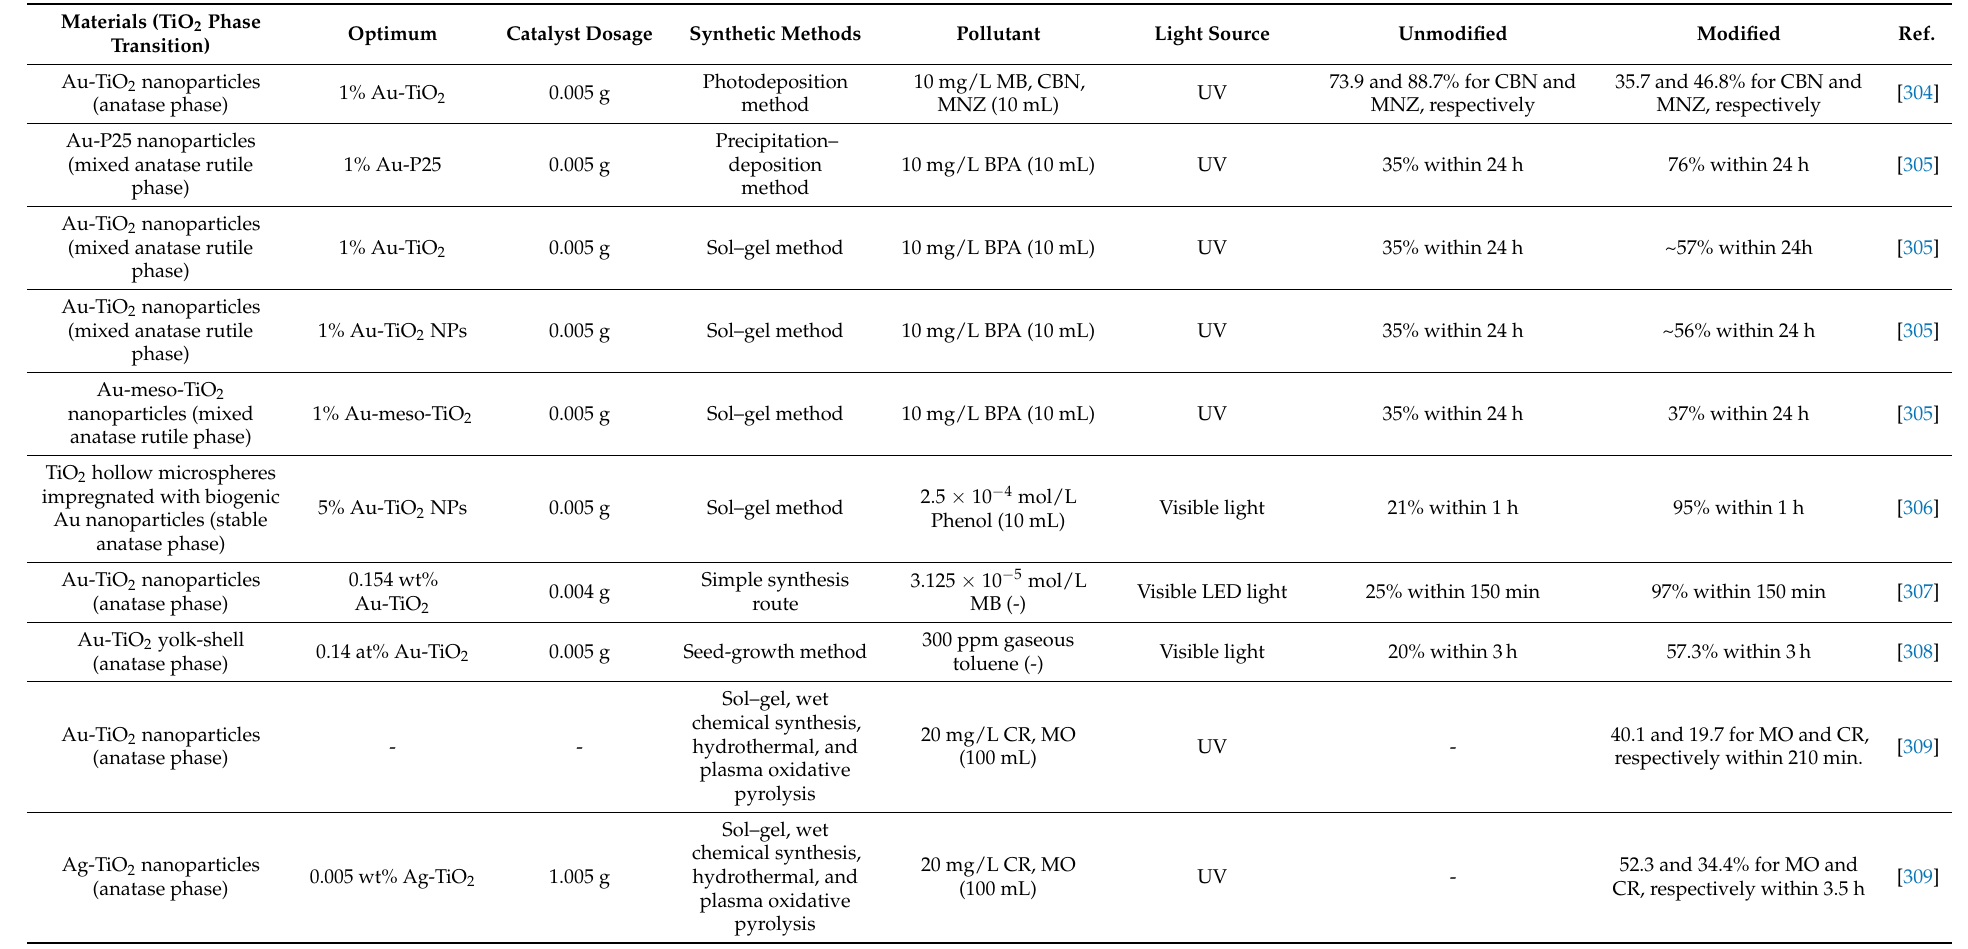
Table 15. Summary of recent progress on Au-TiO 2 photocatalysts for organic pollutants